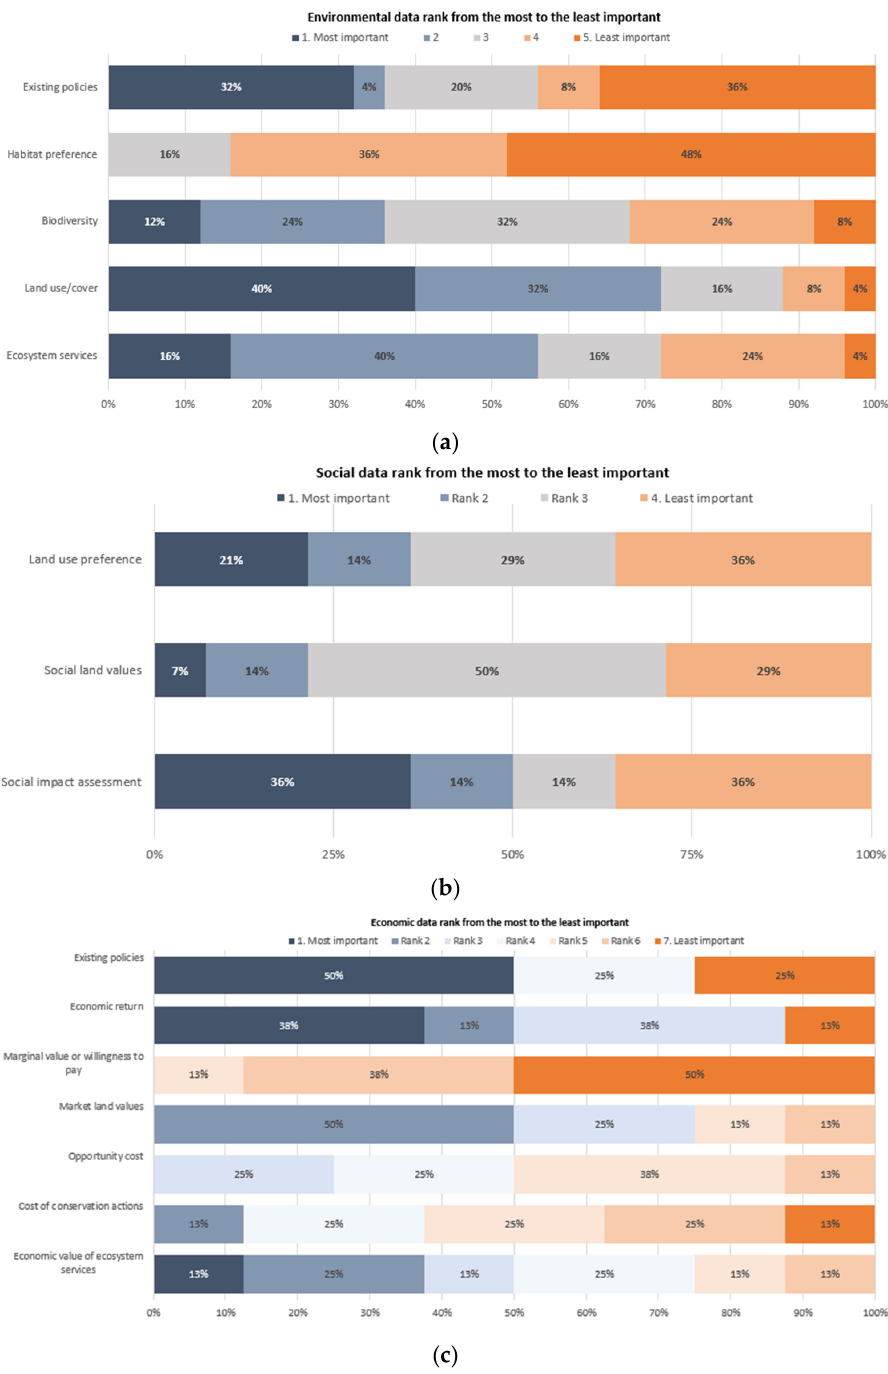
Figure 4. The most to least important data needs for land-use planning identified by experts. ( a ) Environmental (total of 25 responses). ( b ) Social (total of 14 responses). ( c ) Economic (total of 8 responses).